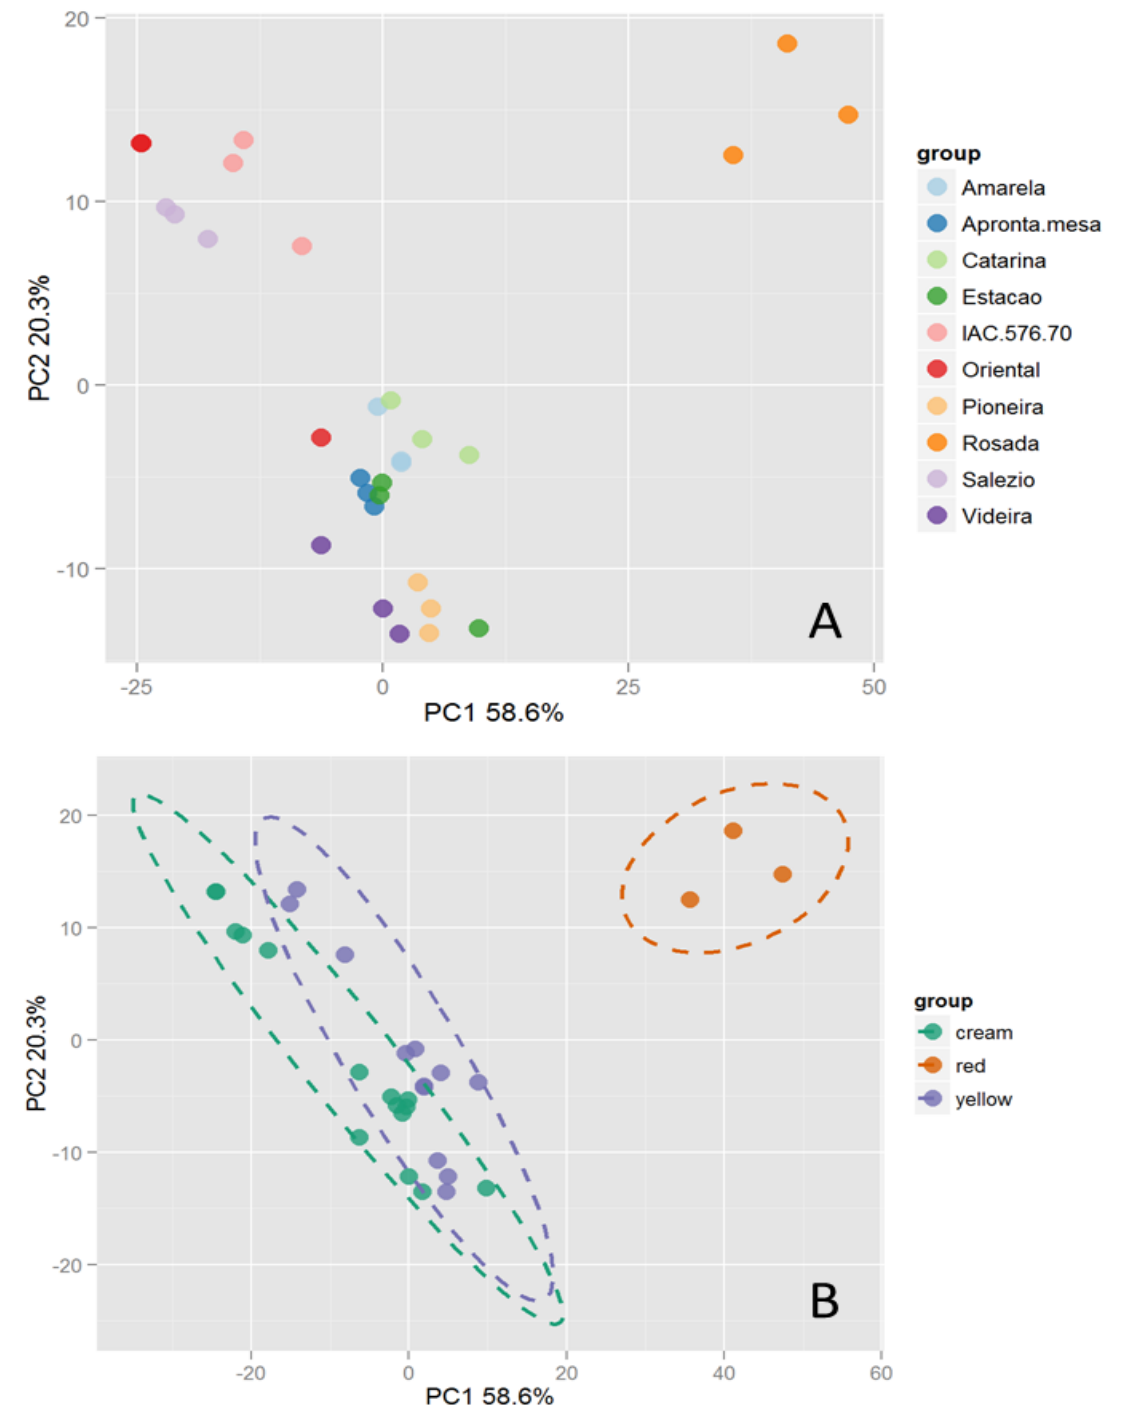
Figure 4: Factorial distribution (principal components 1 and 2) of the UV-Vis spectral data set (200-700 nm) of the organosolvent extract of roots of ten cassava genotypes (A). Graphical demon- stration of factorial distribution (principal components 1 and 2) according to the root flesh color